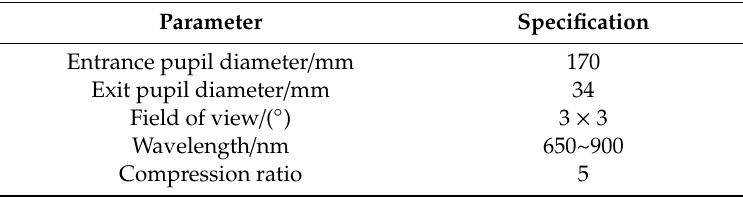
Table 1. Specification of the off-axis four-mirror optical system.